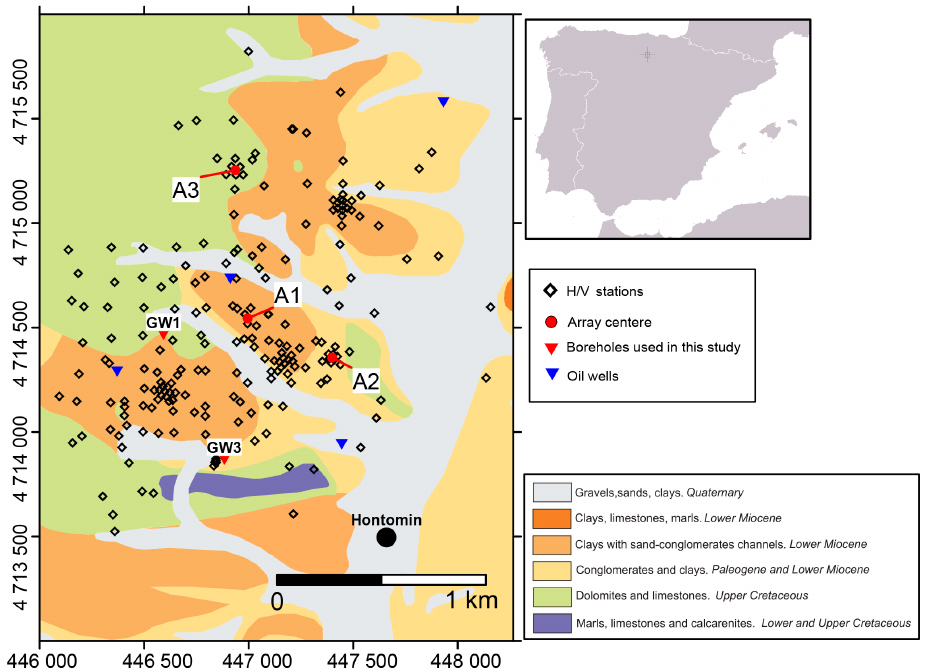
Figure 1. Surficial geological map of the study area (Quintà, 2013) with locations of the H / V measurements, the array centres and the boreholes discussed in this paper (UTM coordinates inm, ETR89 datum). Overview map of the Iberian Peninsula with location of the study